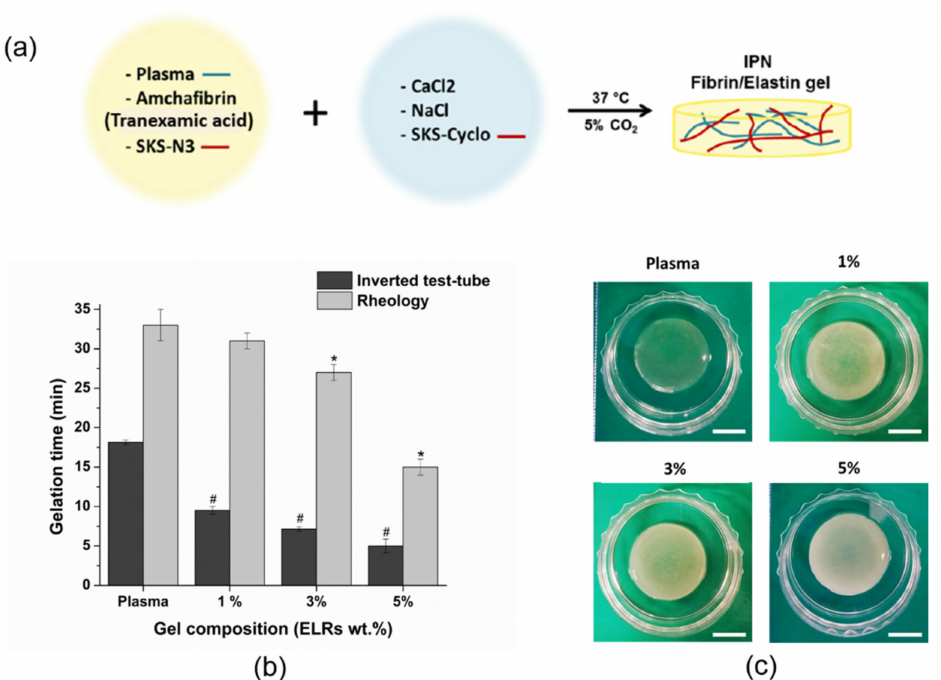
Figure 1. ( a ) Illustration of the components and mixture conditions for the preparation of the hybrid plasma-SKS (serine- lysine-serine sequence) hydrogels; ( b ) Gelation time at 37 ◦ C determined by inverted test tube and rheology methods (data expressed as mean ± standard deviation (SD), n = 3) and the. Analysis of variance (ANOVA) results performed for each hydrogel with respect to plasma samples by rheology at significant level of * p < 0.05 and by inverted test-tube (# < 0.05). ( c ) Digital images of plasma and plasma elastin-like recombinamer polymers (ELRs) hybrid hydrogels in phosphate-buffered saline (PBS) after removal from the vial. The scale bars correspond to 1 cm. Percentages indicate % w / v of elastin content in hybrid